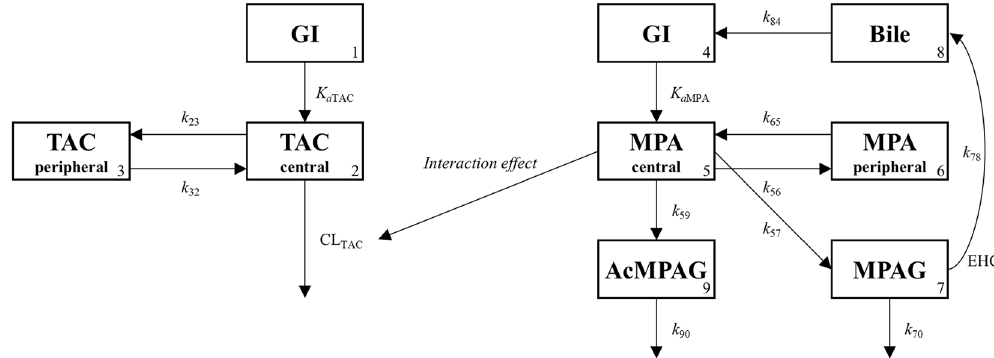
Figure 2. Schematic presentation of a population pharmacokinetic model. Compartments: gastrointestinal tract (GI, 1, 4), central compartment for tacrolimus (2), peripheral compartment for tacrolimus (3), central compartment for mycophenolic acid (5), peripheral compartment for mycophenolic acid (6), compartment for mycophenolic acid 7-O-glucuronide (7), compartment for gall bladder (8), compartment for mycophenolic acid acyl glucuronide (9). TAC, tacrolimus; K a , absorption rate constant; k 23 , k 32 , k 56 , and k 65 , intercompartment rate constants; CL , clearance; MPA, mycophenolic acid; MPAG, MPA 7-O-glucuronide; AcMPAG, MPA acyl glucuronide; k 57 and k 59 , metabolized rate constants for mycophenolic acid; EHC, enterohepatic circulation; k 78 , biliary recirculation of MPAG into GI; k 70 and k 90 , eliminated rate constants; k 84 , gallbladder emptying rate constant; Meal times were used to trigger timing of gall bladder